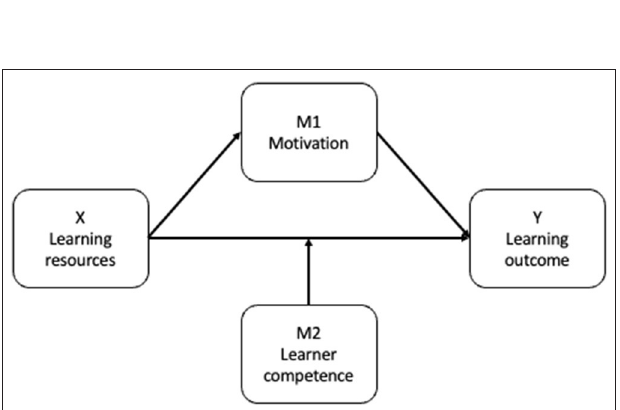
FIGURE 6 | Conceptual diagram with mediator (M1) and moderator (M2)